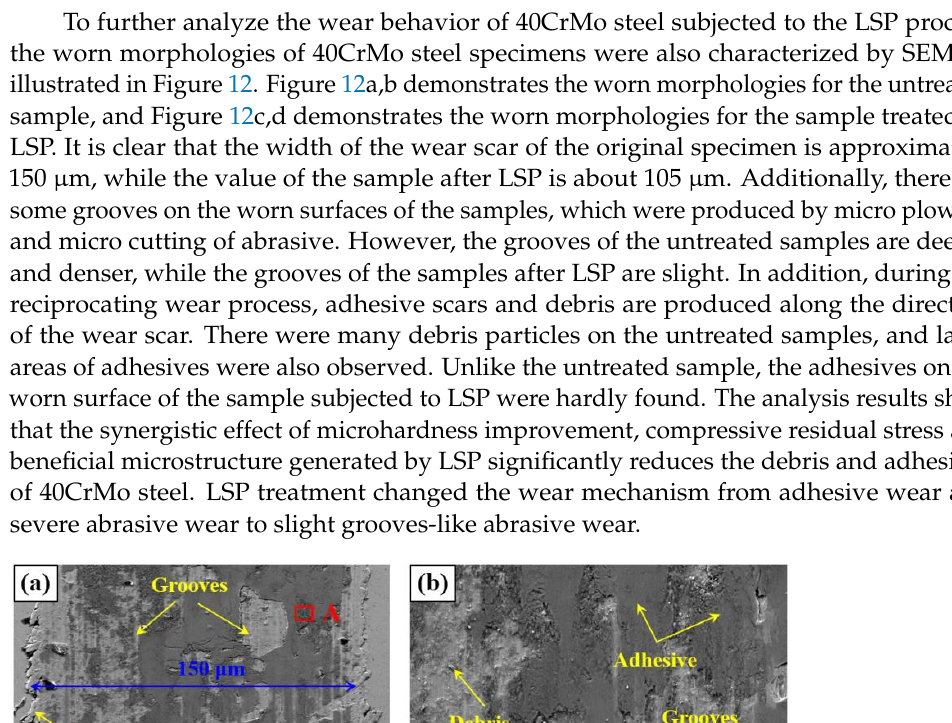
Figure 13. EDS analysis results of the debris in Figure 12. ( a ) corresponds to A area and ( b ) corre- sponds to B area.